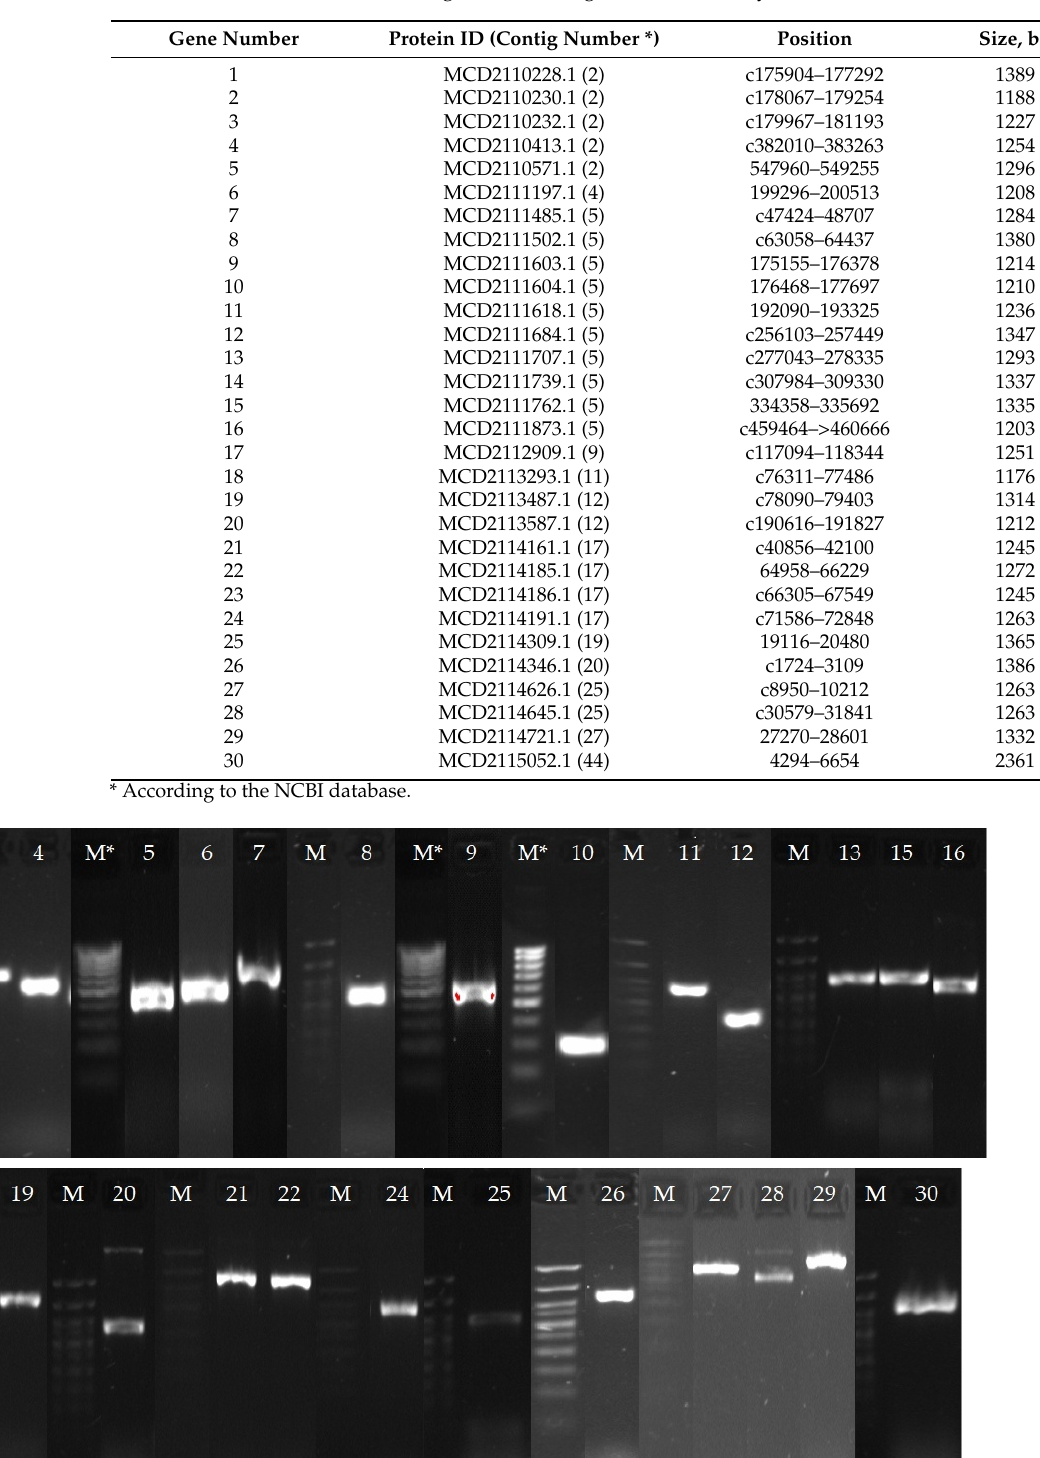
Table 5. R. rhodochrous IEGM 757 genes encoding the CYP450 enzymes.